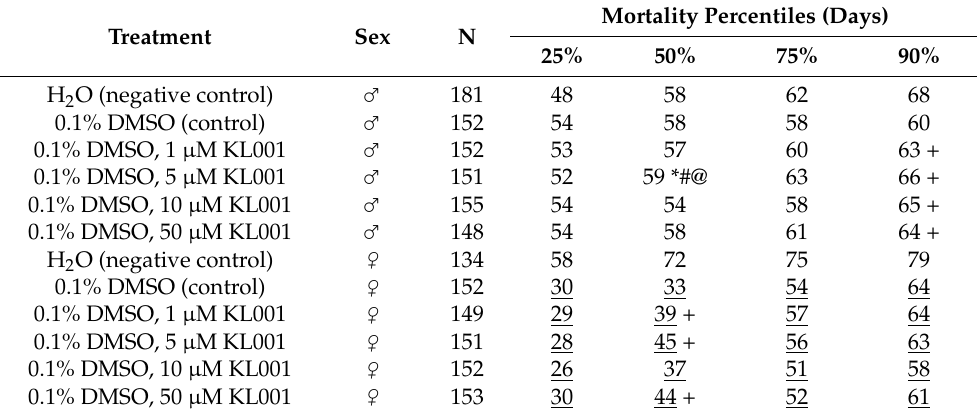
Table 2. The effects of KL001 on Drosophila melanogaster